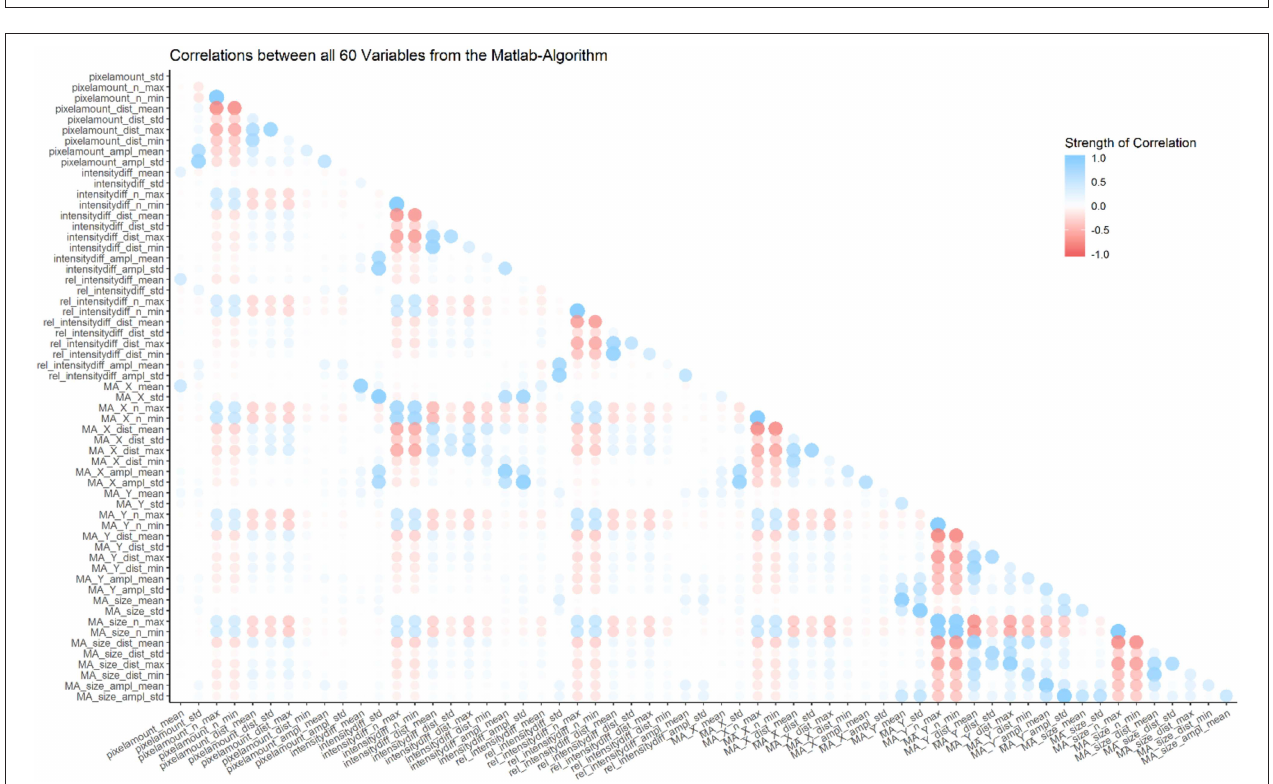
FIGURE 3 | Exemplary curves computed from the raw output of the MATLAB algorithm for one animation clip. (A) shows an example for “Pixels in Avatar” (categories 1 – 3 in Table 2 ), while (B) displays an example for “MA-Size” (categories 4 – 6 in Table 2 ). The trajectories of the curves are used to derive variables such as the number of maxima or the mean amplitude (for a full list of computed variables, see Table 2 and Supplementary Table 1 ).